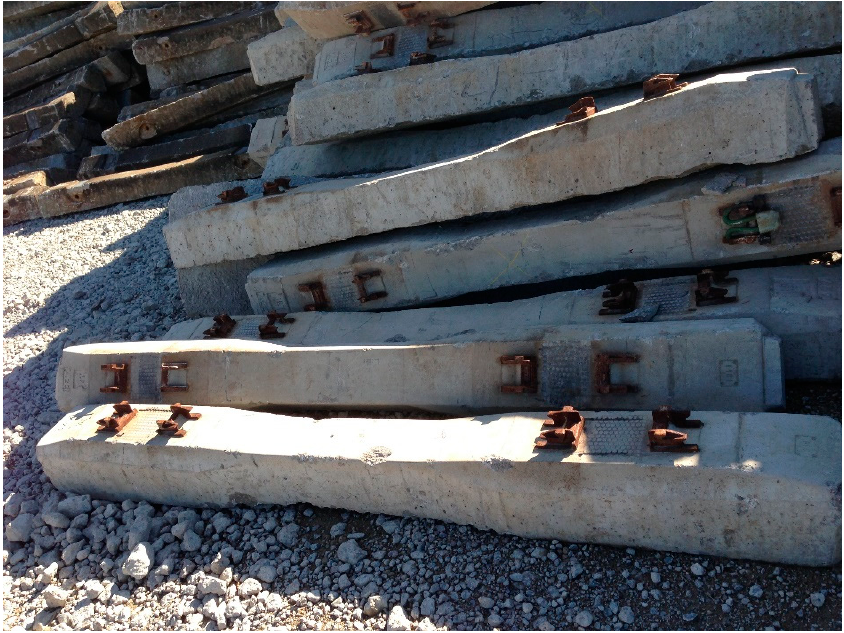
Figure 1. End-of-life railway prestressed concrete sleepers. Concrete is relatively intact in many sleepers after 50 years, raising a concern for better design optimisation. (Courtesy: Abetong